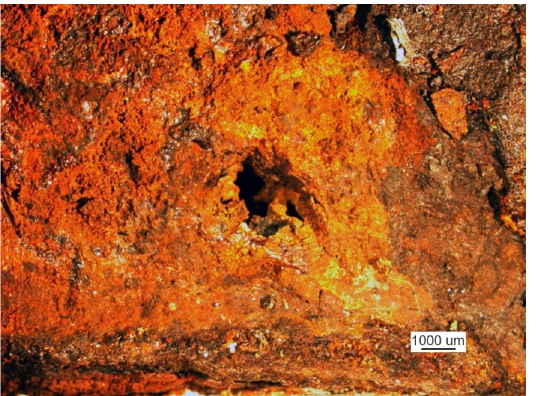
Figure 37. The deep corrosive pit is the presumed origin of the crack (handy-size bulk carrier 30185 DWT). Stereoscopic optical microscopy.